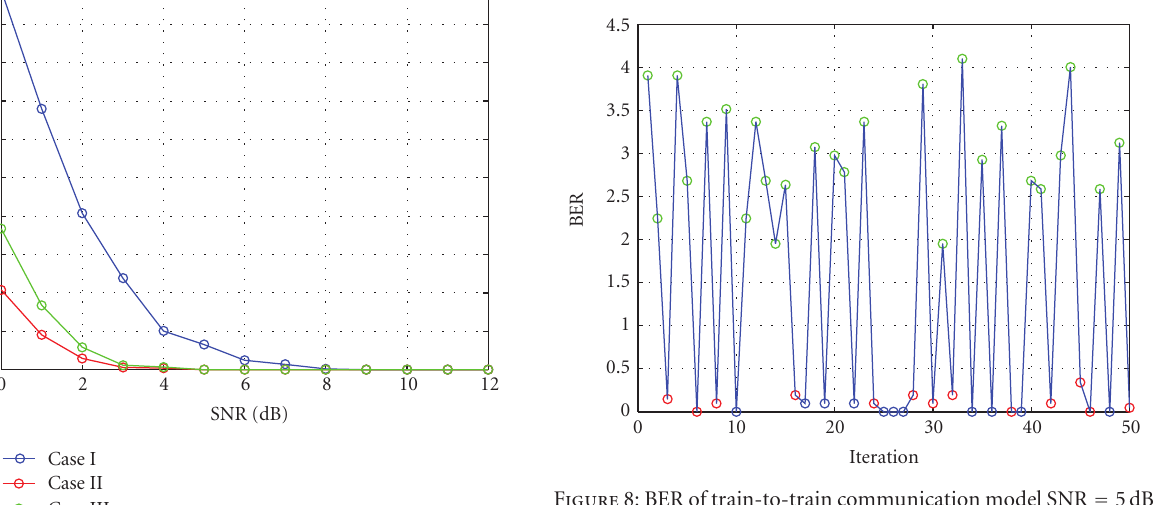
Figure 8: BER of train-to-train communication model SNR = 5dB based on the Poisson process.